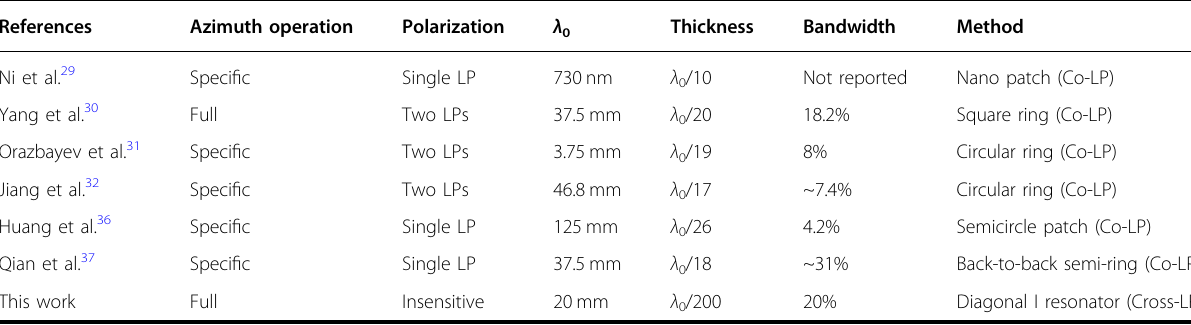
Table 1 Summary of previously reported metasurface